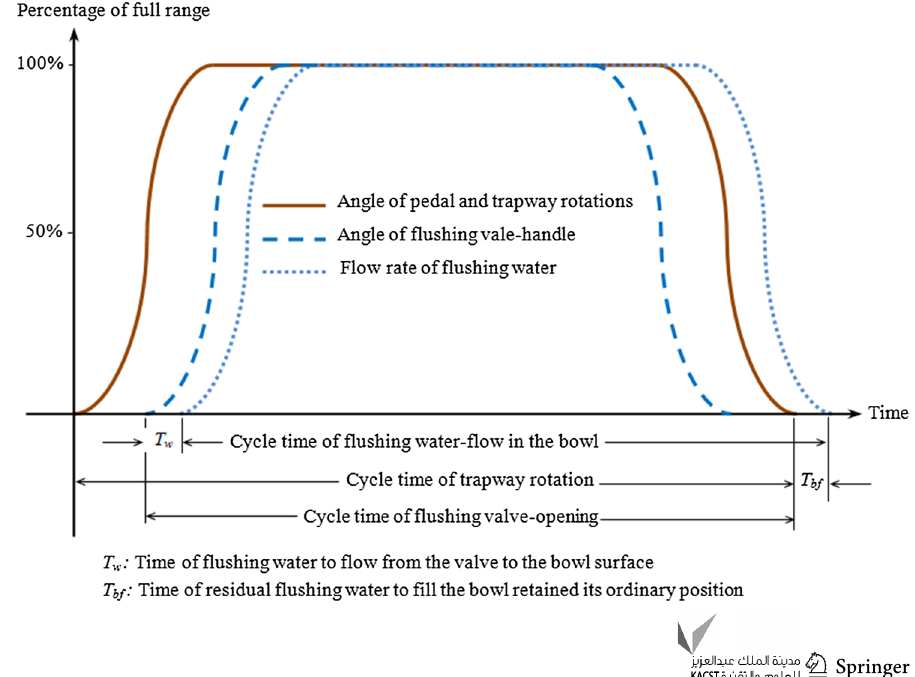
Fig. 9 Timing diagram of the proposed pedal actuated-rotata- ble trap way